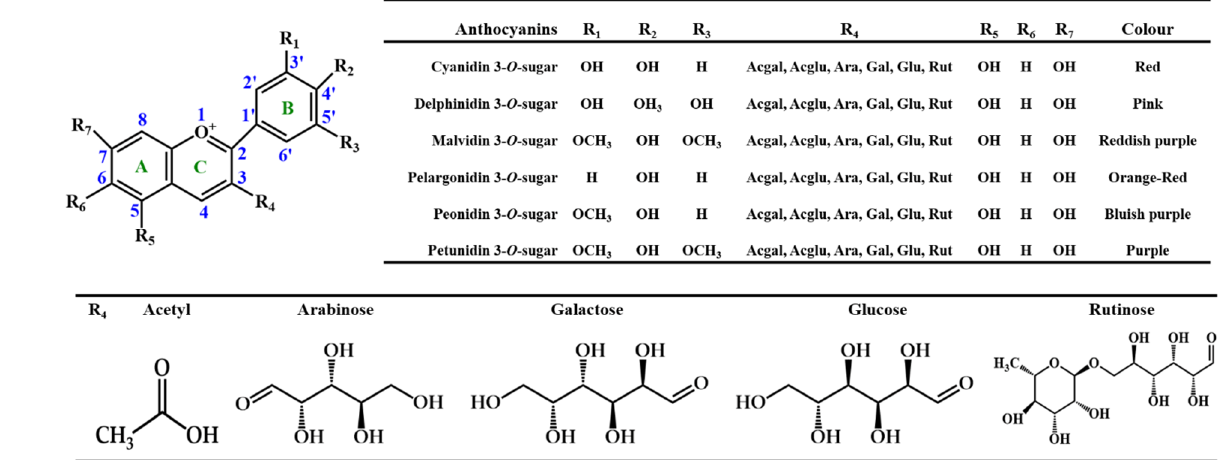
Figure 3. Representation of the main general chemical structure of anthocyanins. Acgal—acetylgalactose; Acglu— acetylglucose; Ara—arabinose; Gal—galactose; Glu—glucose; Rut—rutinoside (adapted from [35,37]).